Question: Which kind of chart has been used to present this data?
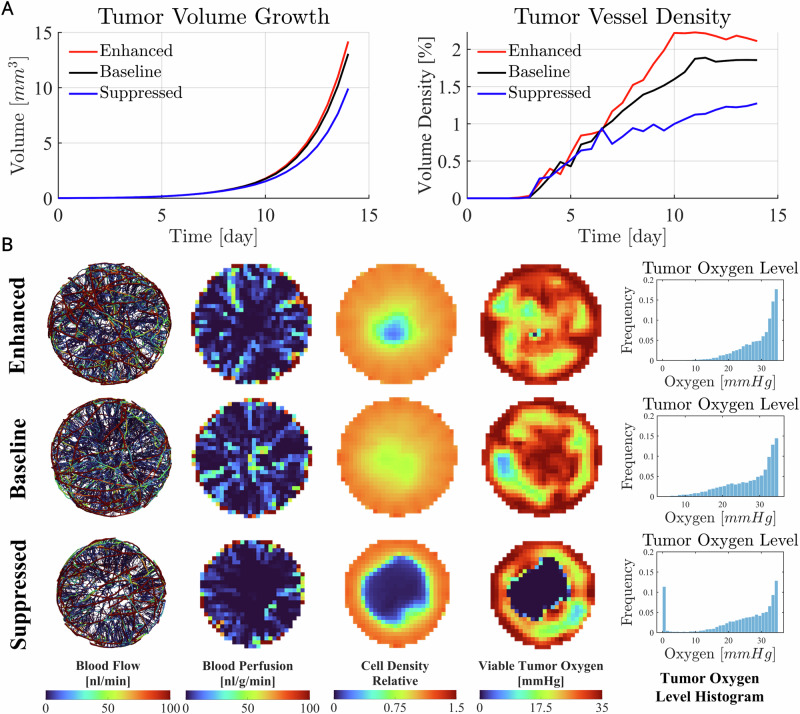
Answer: histogram